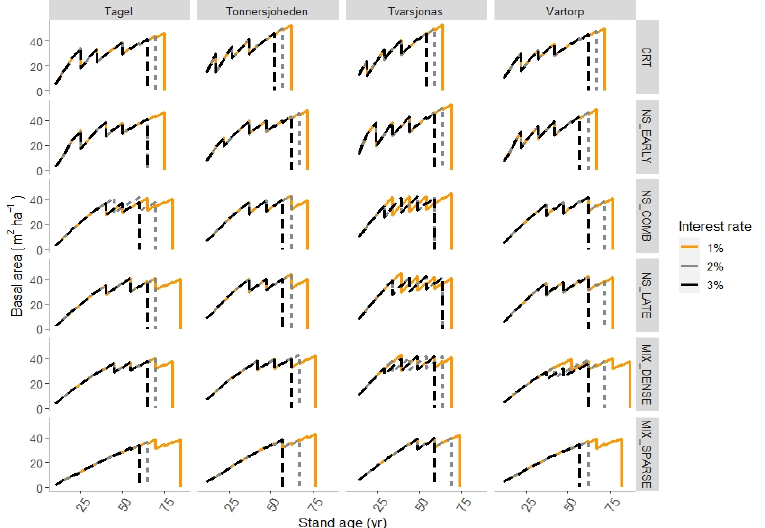
Figure A1. Basal area development of different PCT stands over time at different sites and interest rates. The “birch pulpwood” assortment was used in the simulation. See Figure 3 for an explanation of the PCT treatments.